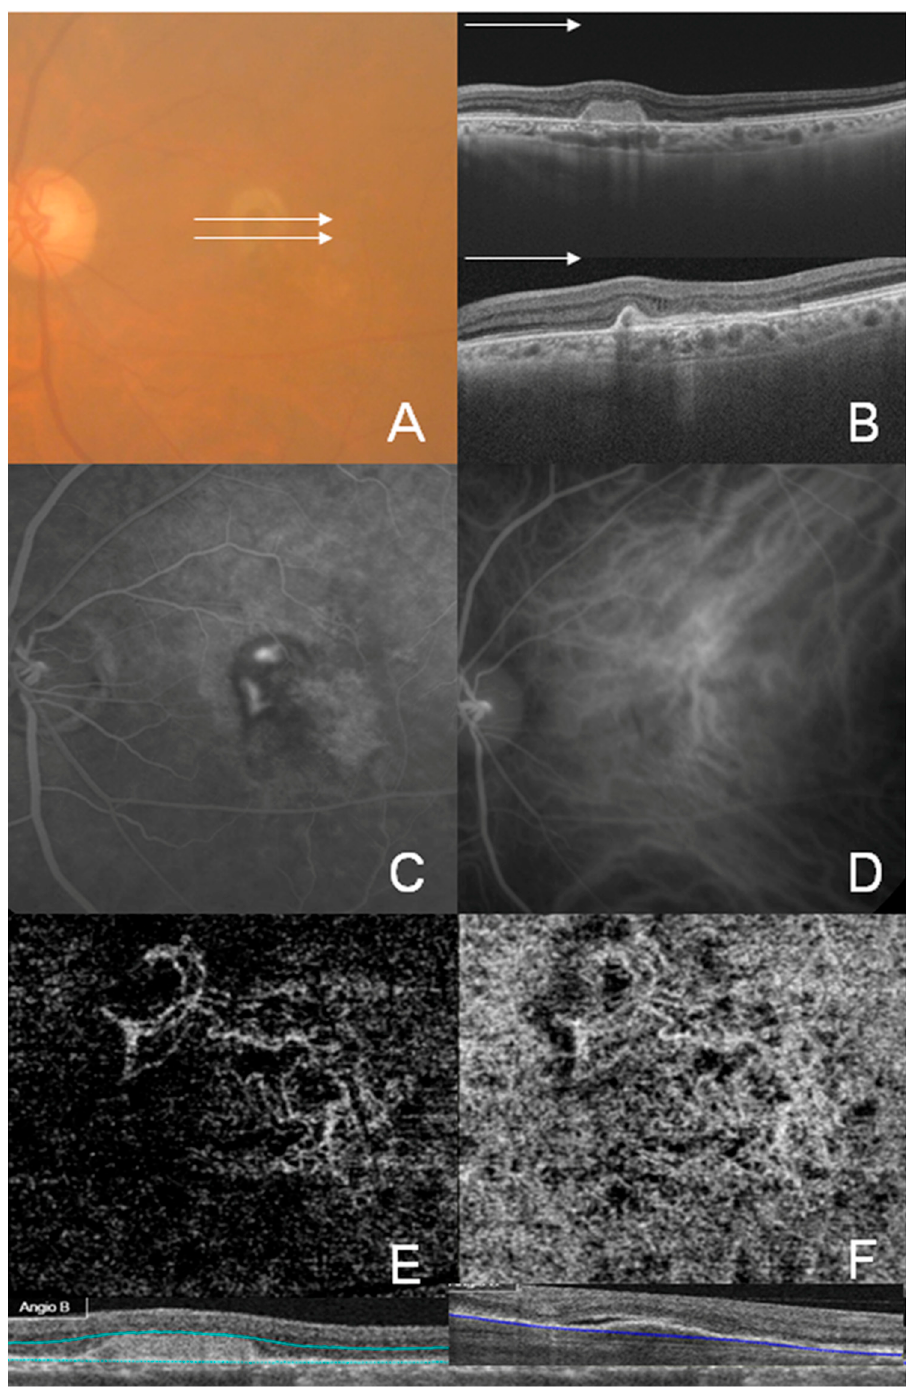
Figure 4. Multimodal imaging of a 60-year-old male showing well-circumscribed (Group A) type 2 choroidal neovascularization (CNV). ( A ) Color fundus photograph obscured due to grade 3 nuclear sclerosis-cataract; ( B ) Swept-source optical coherence tomography (OCT) B-scan image of the horizontal 6 mm of the central fovea (white lines on fundus photograph). ( C , D ) Early phase image of fluorescein angiography ( C ) and indocyanine green angiography ( D ) showing hyper-fluorescent classic CNV lesion. ( E , F ) OCT angiography images of the outer retina layer ( E ) and choriocapillaris ( F ) showing a well-circumscribed CNV network.